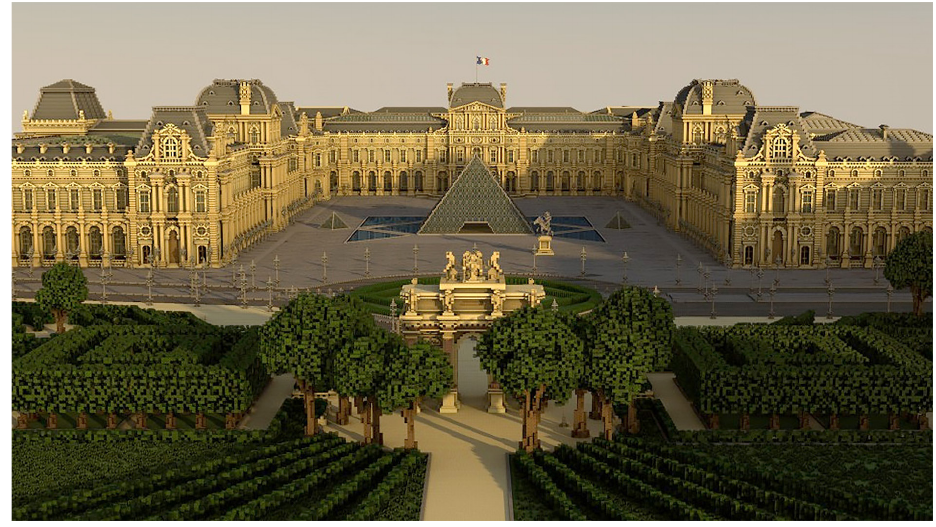
Fig. 5 Persson, M. (2009) . Minecraft, videogame. Stoccolma, SE: